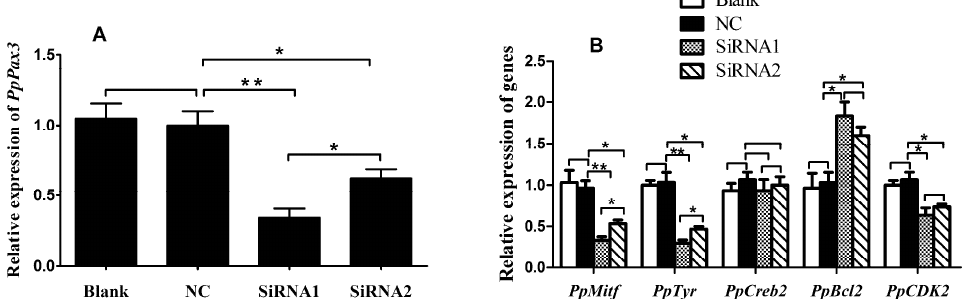
Figure 4. Expression of PpPax3, PpMitf, PpTyr, PpCreb2, PpBcl2 and PpCdk2 after PpPax3 RNA interference (RNAi). ( A ) Expression of PpPax3 . ( B ) Expression of PpMitf, PpTyr, PpCreb2, PpBcl2 and